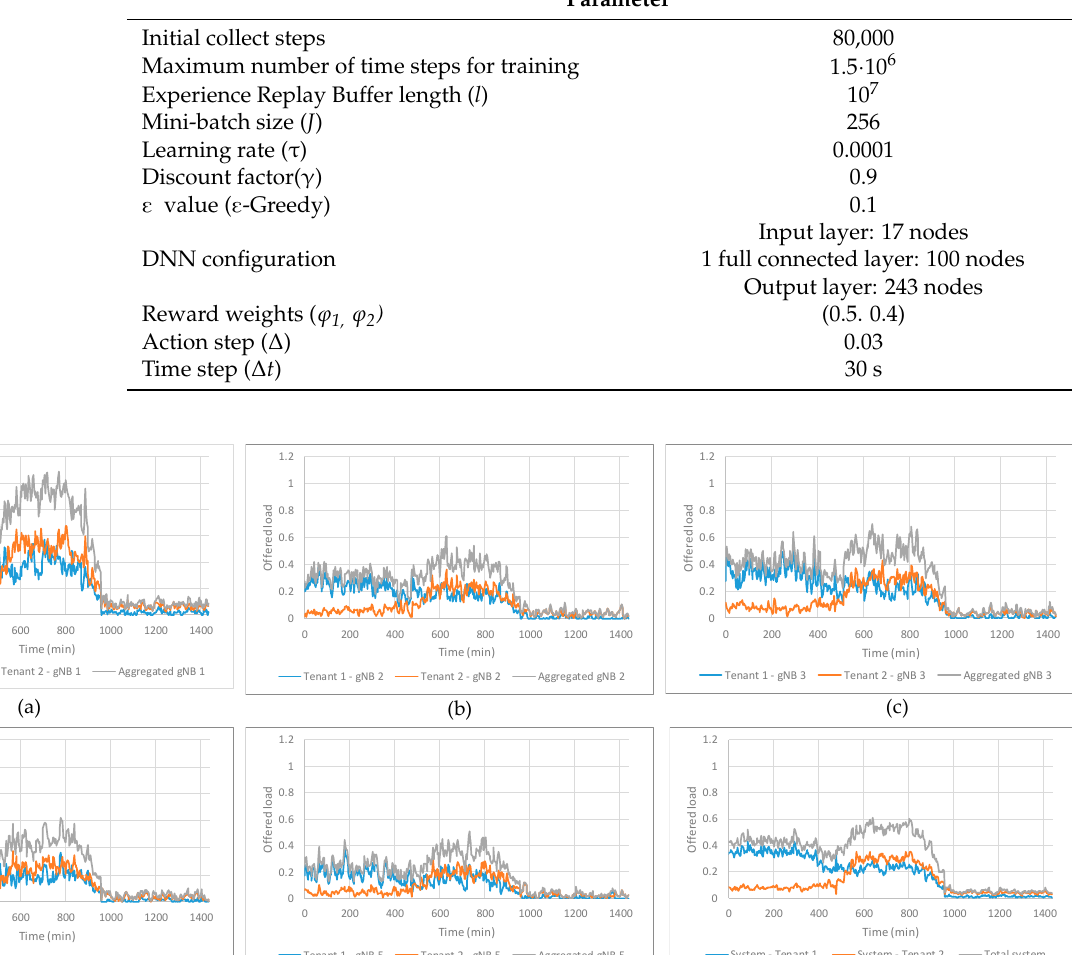
Figure 5. Evolution of the aggregated reward by tenant 1 and tenant 2 during training. Moreover, the visualization model in the RAN NDT also provides Figure 6, which compares the assigned capacity per tenant by the learnt policy after convergence to their respective offered loads in the different gNBs (subplots (a)–(e)) and system level (subplot (f)). In subplots (a)–(e) both the offered loads and assigned capacities are normalized to the gNB capacity. The results in these subplots illustrate that the assigned capacity per cell adapts to the offered load in all gNBs. Moreover, subplot (f) compares the offered loads and assigned capacities to both tenants in aggregated terms over all gNBs, both normal- ized to the system capacity. From this subplot, the fact that the learnt policies allow satis- fying the SAGBR k requirement can be observed as the aggregated offered loads per tenant,